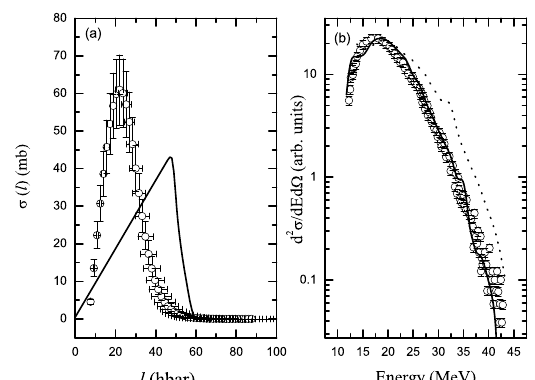
Figure 2: (a) The comparison of the experimental spin distributions (circles) with CCDEF calculations (solid line) for 32 S + 48 Ti at E lab = 125 MeV. (b) The explana- tion of experimental α -particle spectrum (circles) by the spectrum generated (solid line) using experimental spin distribution in PACE. The dotted line corresponds to default calculations using